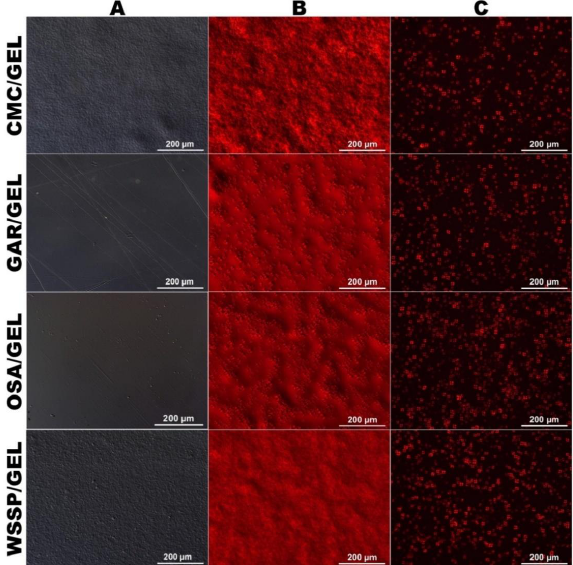
Figure 1. Microtopographies of AstaSana astaxanthin (AST)-free ( A ) and 1% AST-supplemented films (B-C) obtained from the 75/25 blends of polysaccharides (carboxymethyl cellulose (CMC), gum Arabic (GAR), octenyl succinic anhydride starch (OSA), and water-soluble soy polysaccharides (WSSP)) and gelatin (GEL). ( A , B ) — unpolarized light; ( C ) — polarized light.